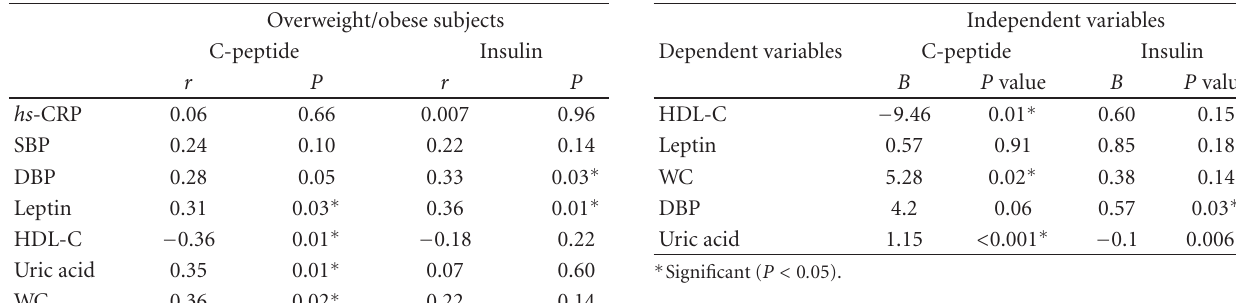
Table 2: Coe ffi cients of simple correlation ( r ) of fasting C-peptide versus fasting insulin with studied parameters in overweight/obese subjects ( n = 45).